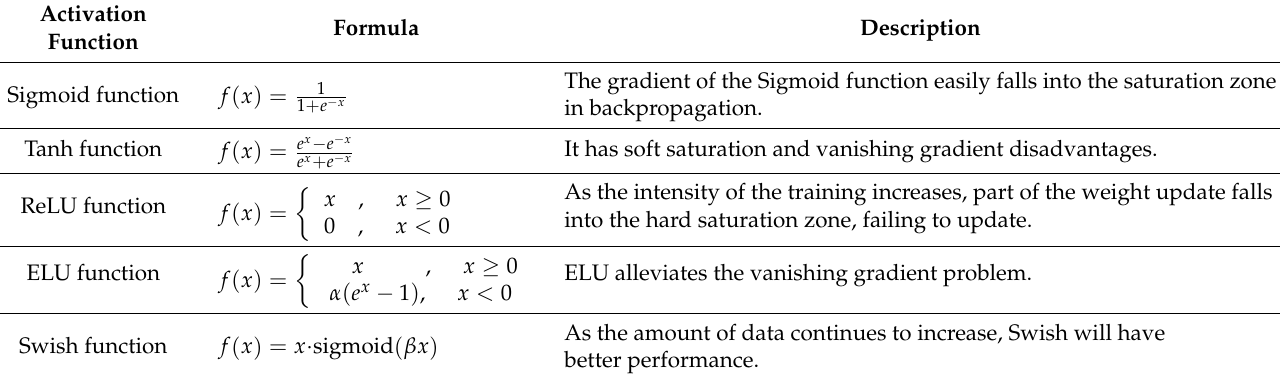
Table 1. The common activation